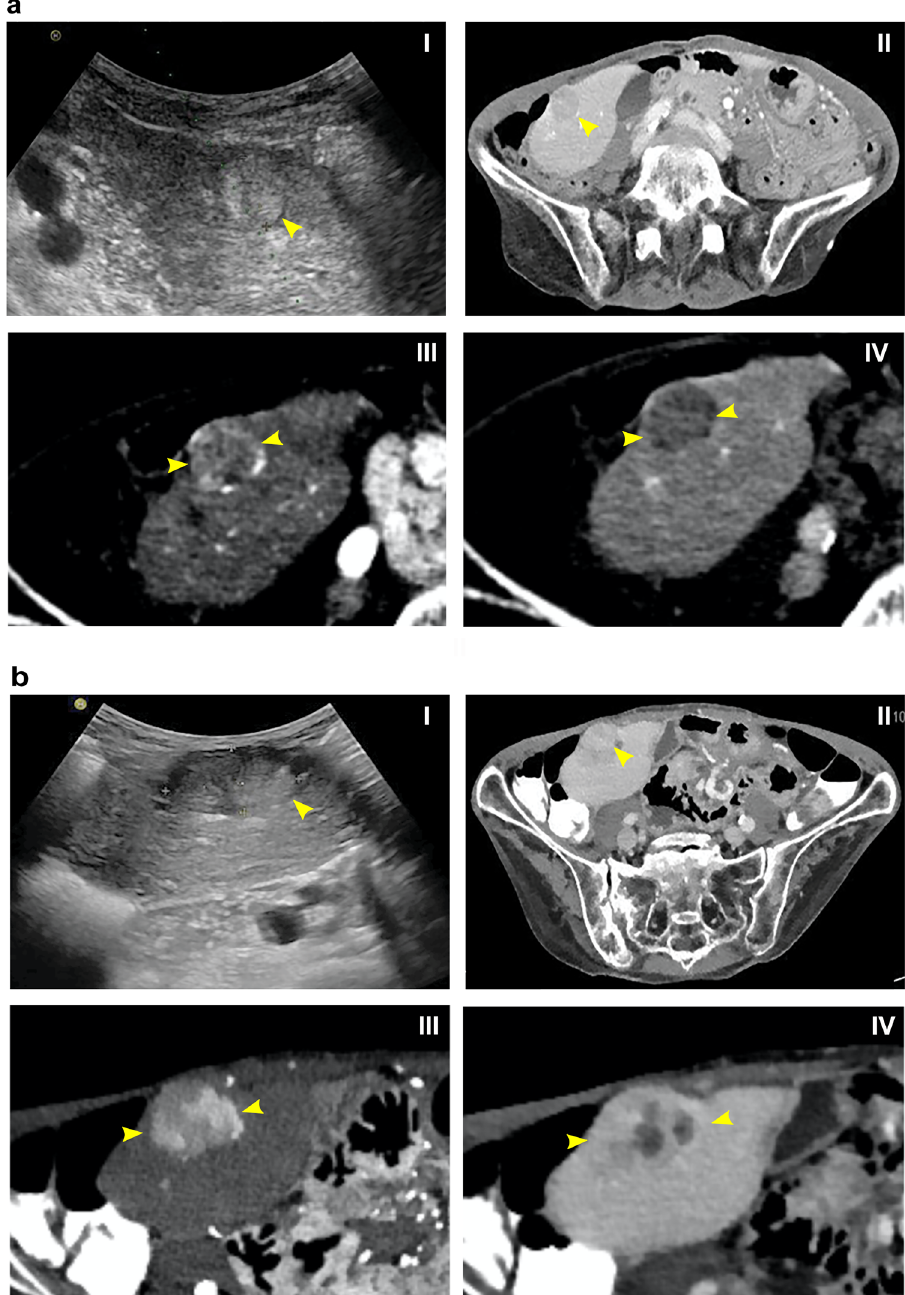
Fig. 1 Radiological imaging of the liver nodule at different time points. a In the initial imaging, abdominal ultrasound shows a solitary, roundish nodule with a mosaic pattern, in the liver (I). Axial contrast computerized tomography (CT) scan (II) of the abdomen shows a partially cystic nodule (maximum diameter 18 mm) in liver segment V. The arterial phase shows a hyperenhancing lesion (III), the portovenous phase demonstrates typical wash-out in comparison to surrounding liver tissue (Liver Reporting & Data System (LI-RADS) 4 classi fi cation) (IV). b A follow-up ultrasound (I) and contrast CT scan (II) were performed. The arterial phase CT scan shows a 32 mm hyperenhancing lesion with inhomogeneous contrast up-take, threshold growth more than 50%. The portovenous phase demonstrates wash-out and nodule-in-nodule pattern (LI-RADS 5 classi fi cation). Arrows highlight the tumor (Supplementary Fig. 2). The mutations shared by all samples included missense variants in ATG5 (T214A) coupled with the LOH of the other allele. Of note, alterations in this gene were previously reported in the pathogenesis of FNH in mouse models 28 . Other shared mutations were observed in ANGPT1 (Q162K), the expression of which has been found to be dysre- gulated in other FNH lesions 8 , and in HNRNPA2B1 (D164G), which has been reported as a hepatic mutational cancer driver 29 .